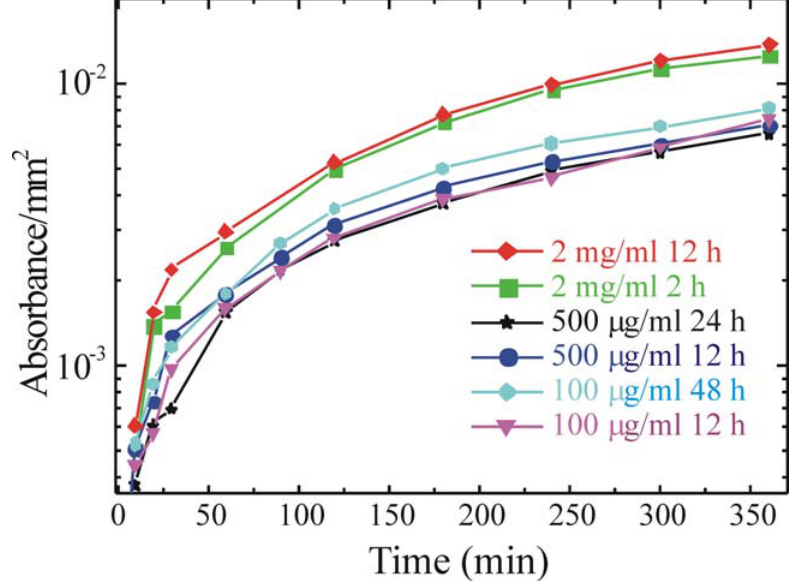
Figure 6. Glucose oxidase activity as a function of time for samples immersed in: 2 mg/mL for 12 h (red rhombuses) or 2 h (green squares); 500 μ g/mL for 24 h (black stars) or 12 h (dark blue circles); 100 μ g/mL for 48 h (light blue symbols) or 12 h (magenta